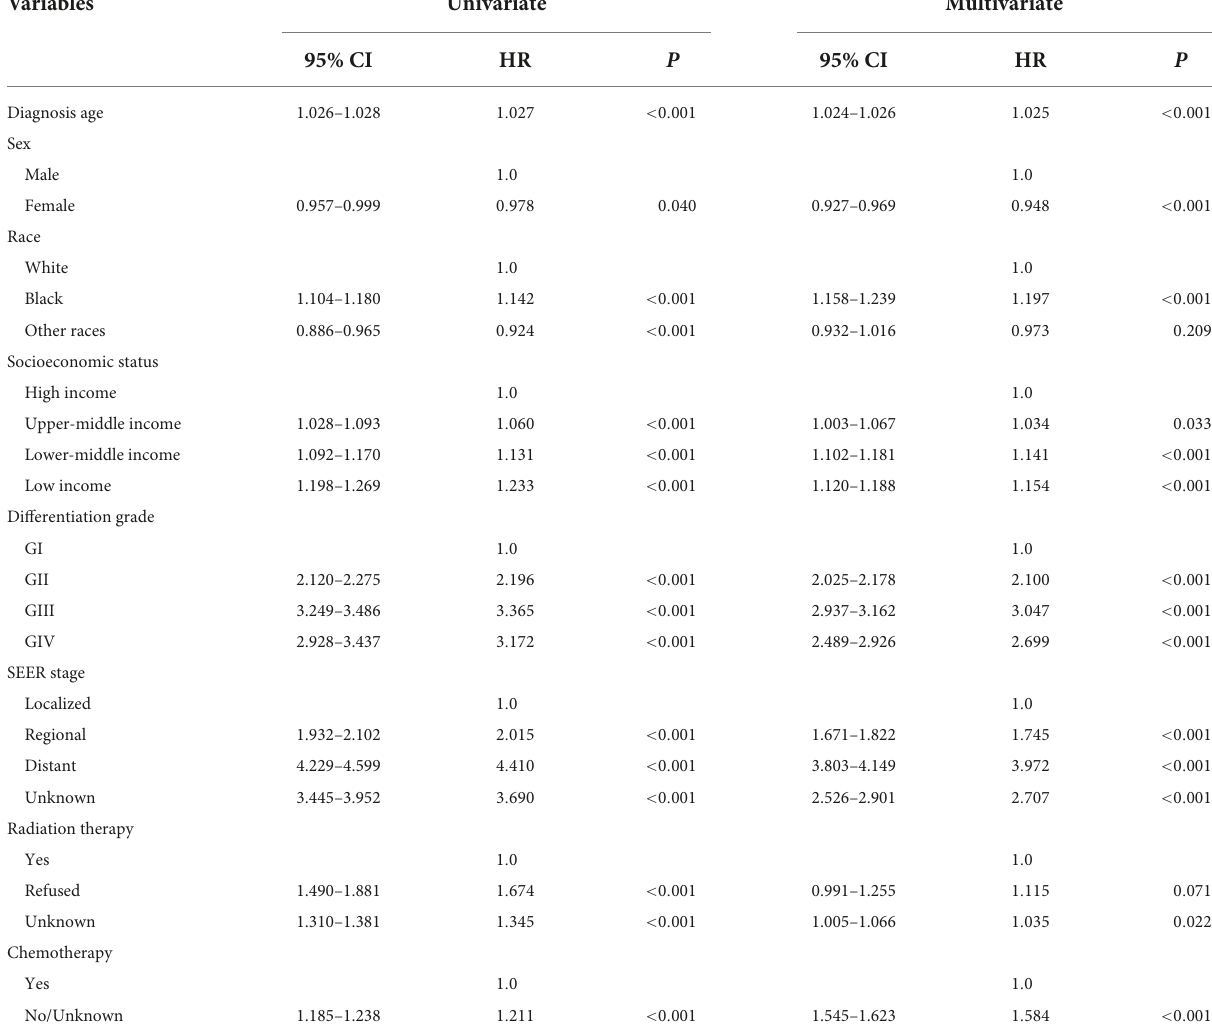
TABLE 2 Summary of Cox regression analysis of survival time of patients with pancreatic cancer